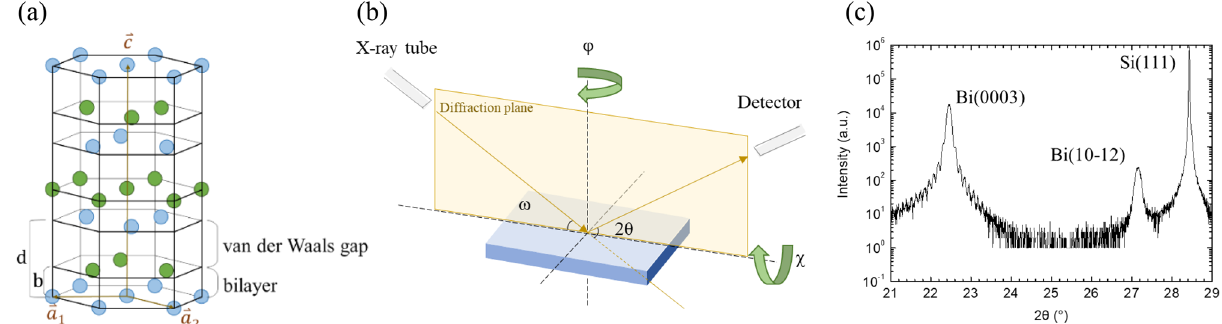
Figure 1. ( a ) Schematic diagram of rhombohedral Bi lattice drawn in a hexagonal lattice. The two basis atoms are represented by light blue and light green balls, respectively. Parameter b and d are the bilayer thickness and the distance between two adjacent bilayers, respectively. ( b ) Schematic diagram of the HRXRD measurement setup. ( c ) ω-2θ scan result of Bi thin film deposited on Si (111). The thickness of the film is around 80 nm calculated from the thickness fringe. *(a), (b) were created using Microsoft Office 2019 Pro Plus—URL: https:// docs. micro soft. com/ en- us/ deplo yoffi ce/ offic e2019/ overv